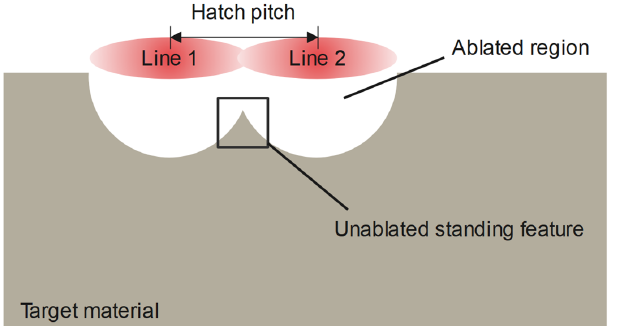
Figure 1. Illustration of the unablated standing feature between parallel lines with a large hatch